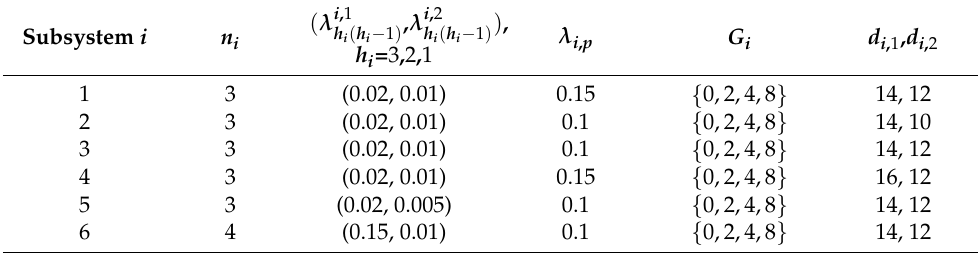
Table 2. Model parameters in the operation mechanism of each